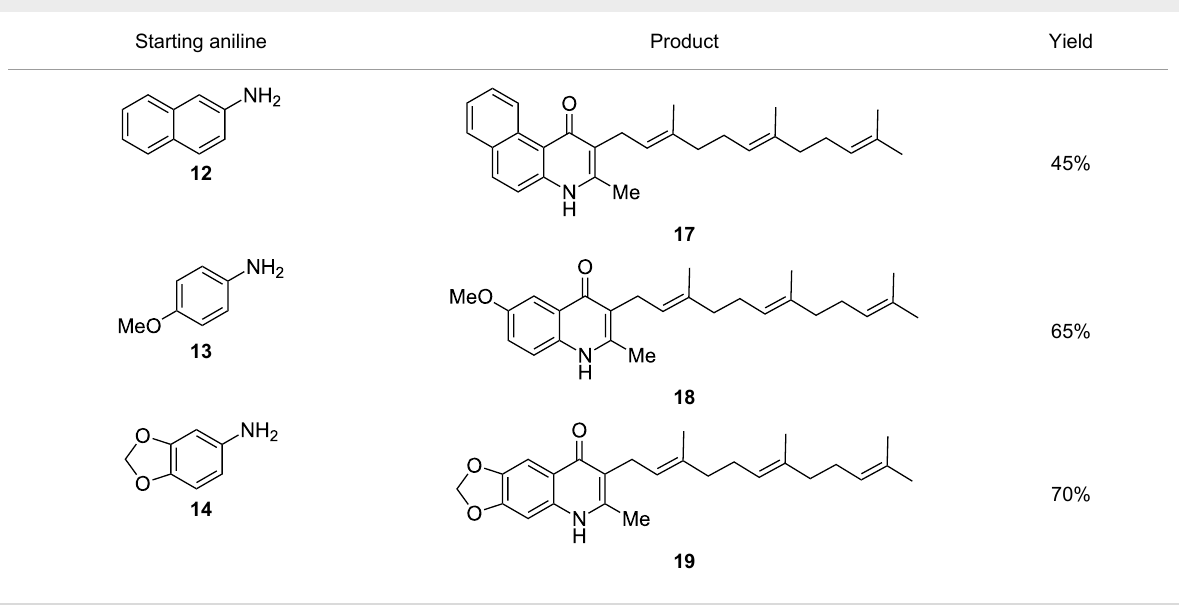
This method allowed for the rapid gram-scale synthesis of aurachin D (max. 1.1 g made in this work) with good yields and in a minimum of steps, which has to be compared to the extrac- tion yield of the natural product. Indeed from a culture batch of 60 L, the production of compound 4 by Stigmatella